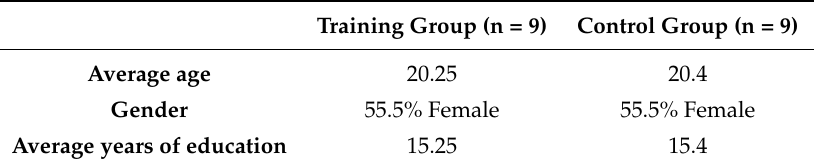
Table 5. Characteristics of the training and control